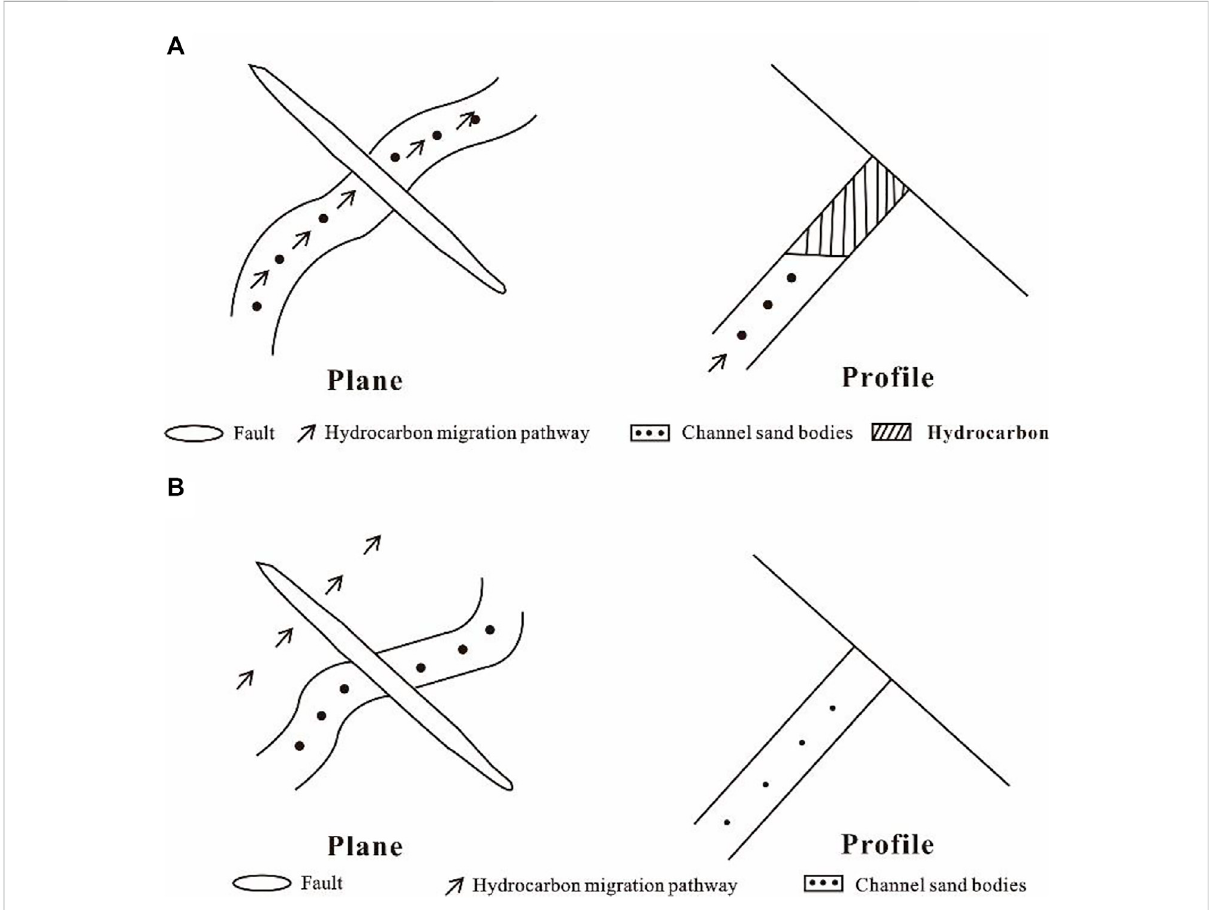
Schematic of typical faults for hydrocarbon accumulation in a slope area; (A) Effective faults for hydrocarbon accumulation; (B) Non-effective faults for hydrocarbon